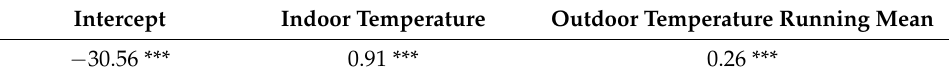
Table 5. Coefficients of the logistic regression model to simulate ceiling fan operation (*** = p < 0.001, R 2 = 0.10).